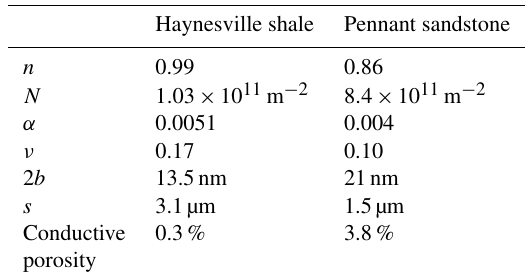
Table 3. Fit parameters for the capillary tubes bundle model ap- plied to describe the permeability of Haynesville shale and Pennant sandstone at low effective pressures, when the permeabilities are not strikingly different. n is the pore pressure multiplier for the per- meability data, N is the number of pores intersecting a 1m 2 area normal to the flow path, a is the pore shape aspect ratio, and ν is the Poisson ratio; 2 b is the mean short dimension (nm) of the elliptical cross section, and s is the average pore spacing